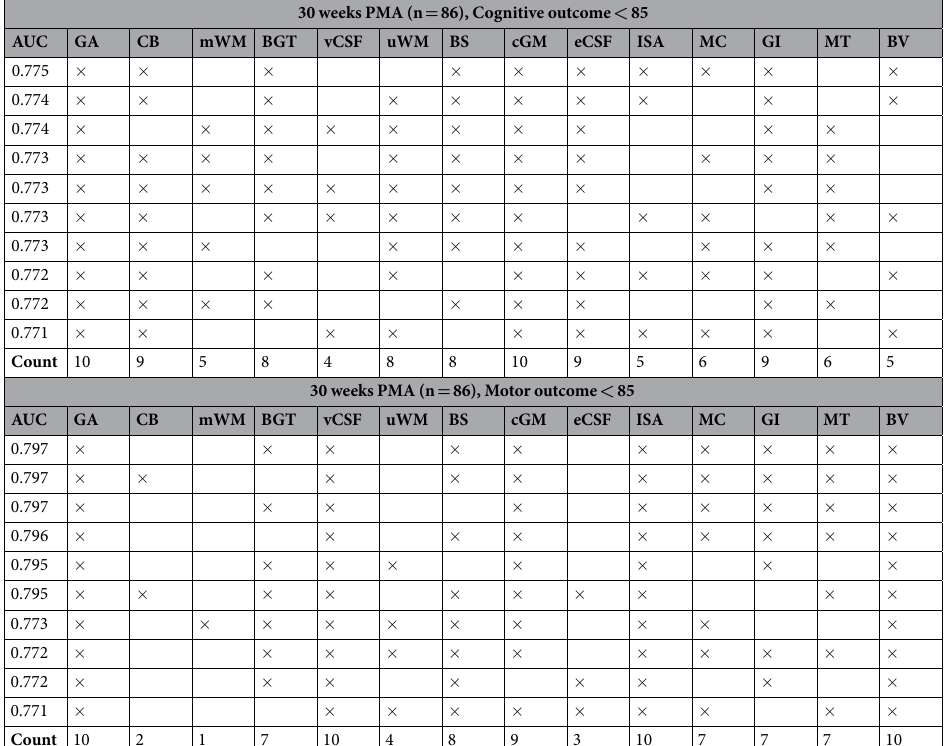
Table 2. AUCs for the 10 best performing combinations of descriptors for cognitive (top) and motor (bottom) outcome based on the images acquired at 30 weeks PMA. GA: gestational age, CB: cerebellum volume, mWM: myelinated white matter volume, BGT: basal ganglia and thalami volume, vCSF: ventricular cerebrospinal fluid volume, uWM: unmyelinated white matter volume, BS: brain stem volume, cGM: cortical grey matter volume, eCSF: extracerebral cerebrospinal fluid volume, ISA: inner cortical surface area, MC: global mean curvature, GI: gyrification index, MT: median cortical thickness, BV: brain volume. The bottom row shows in how many of the combinations each descriptor is